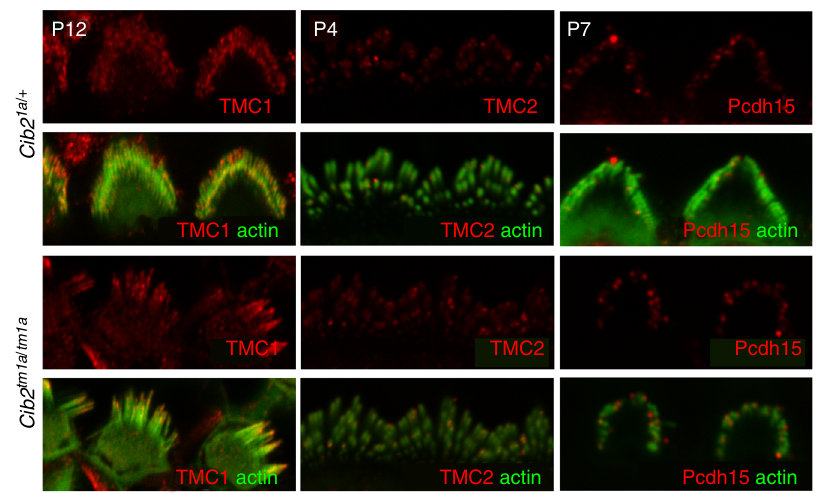
Fig. 6 CIB2 de fi ciency does not mislocalize TMC1, TMC2 and Pcdh15 from the auditory hair cell stereocilia. Confocal images showing IHC stereocilia of Cib2 tm1a/ + and Cib2 tm1a/tm1a mice immunostained with TMC1, TMC2, and Pcdh15 antibodies ( red ) and actin was labeled with phalloidin ( green ) at P12, P4 and P7 correspondingly. Scale bar: 10 μ